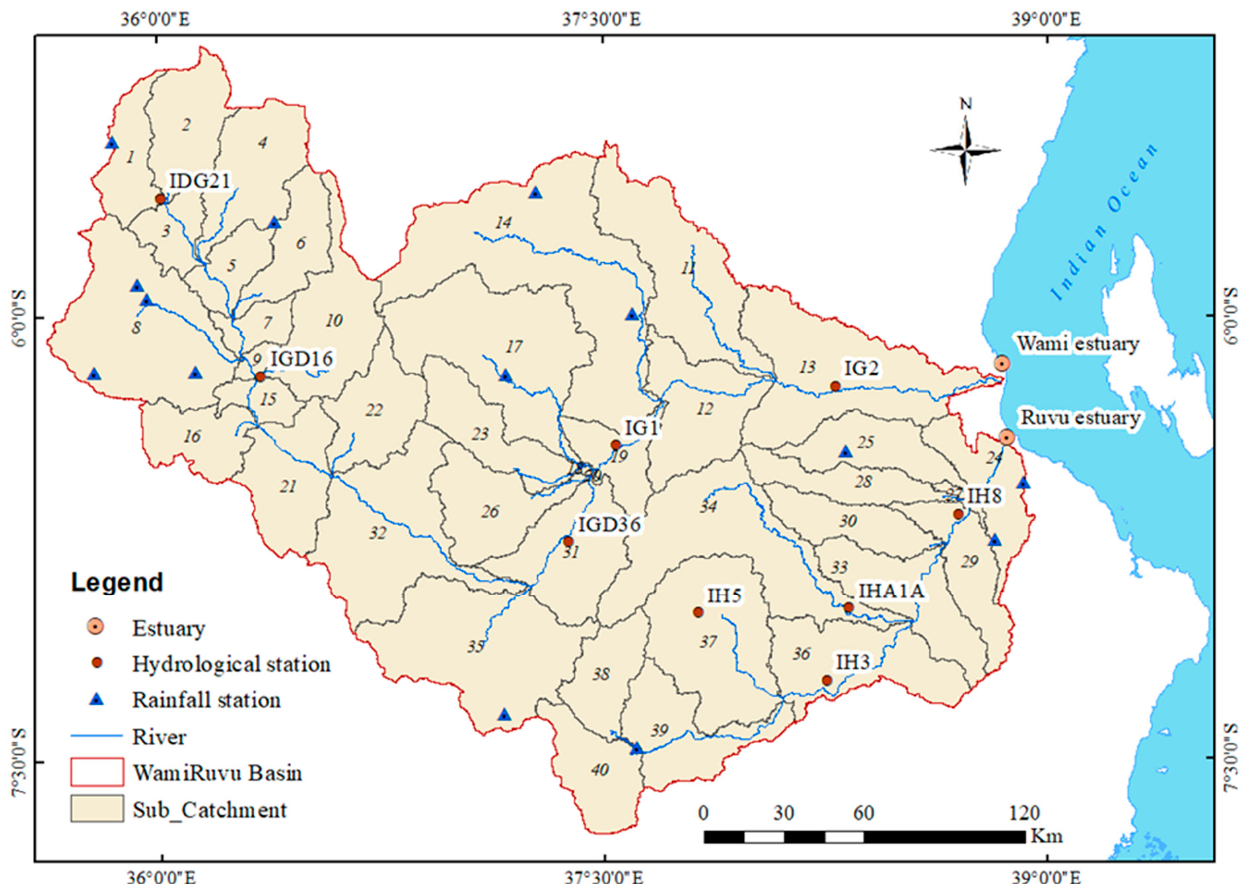
Figure 5. The delineated stream and sub-stream networks of the Wami–Ruvu Basin, Tanzania.